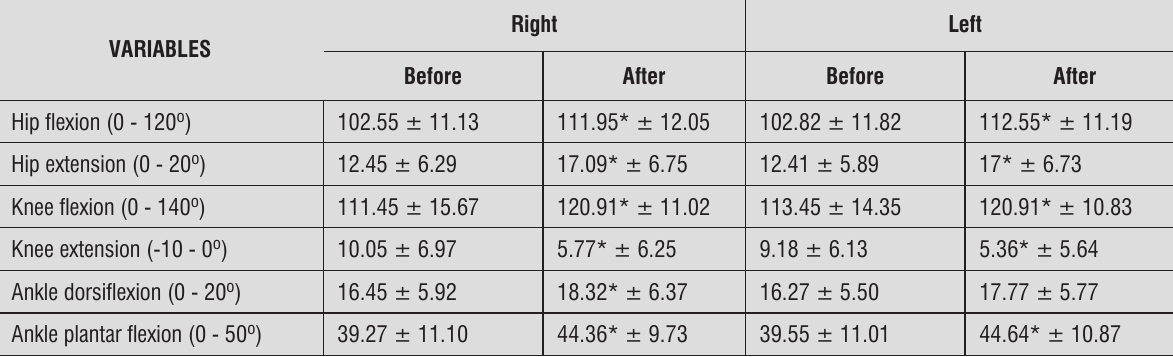
Right Left Before AfterBefore After